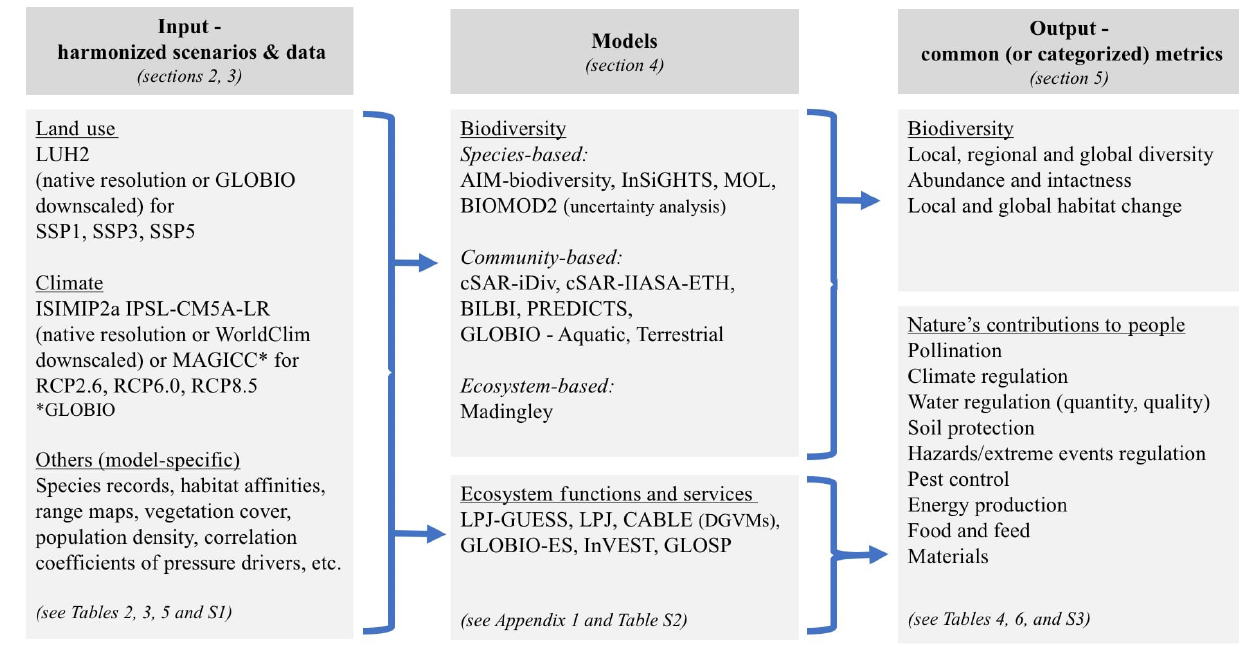
Figure 1. Input–models–output flowchart of